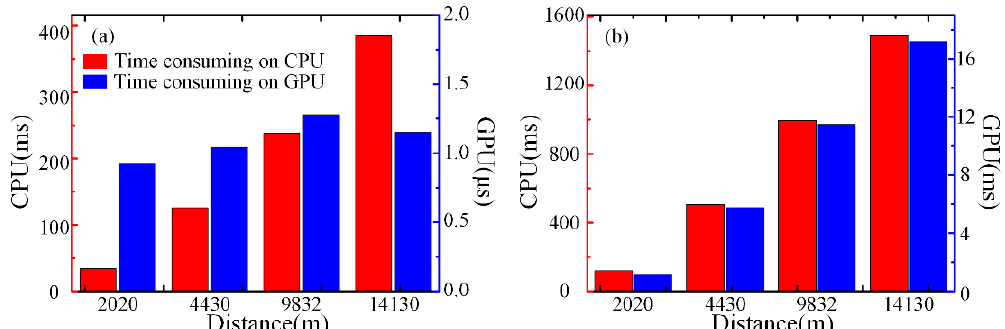
Figure 15. The time contrast between CPU and GPU under different distances for ( a ) the differential accumulation algorithm and ( b ) the FFT processing.